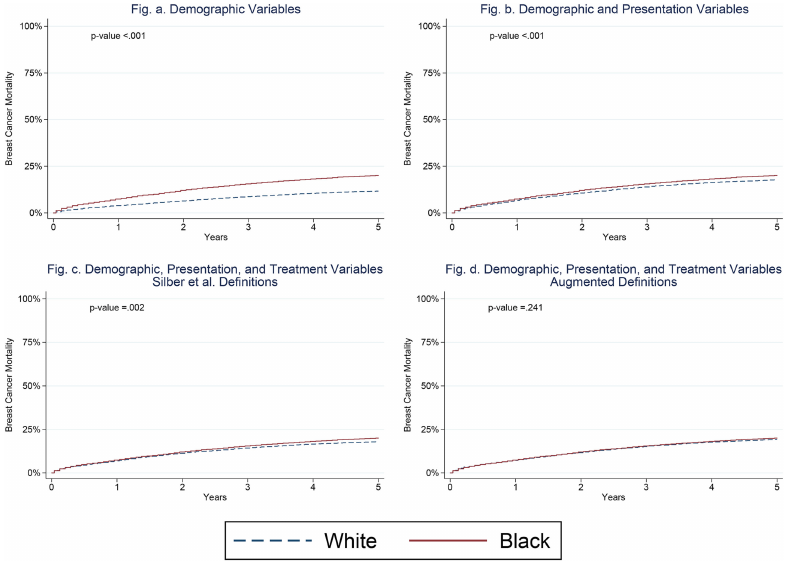
Breast Cancer Mortality Estimates Under Various Matching Schemes for Cases Diagnosed,